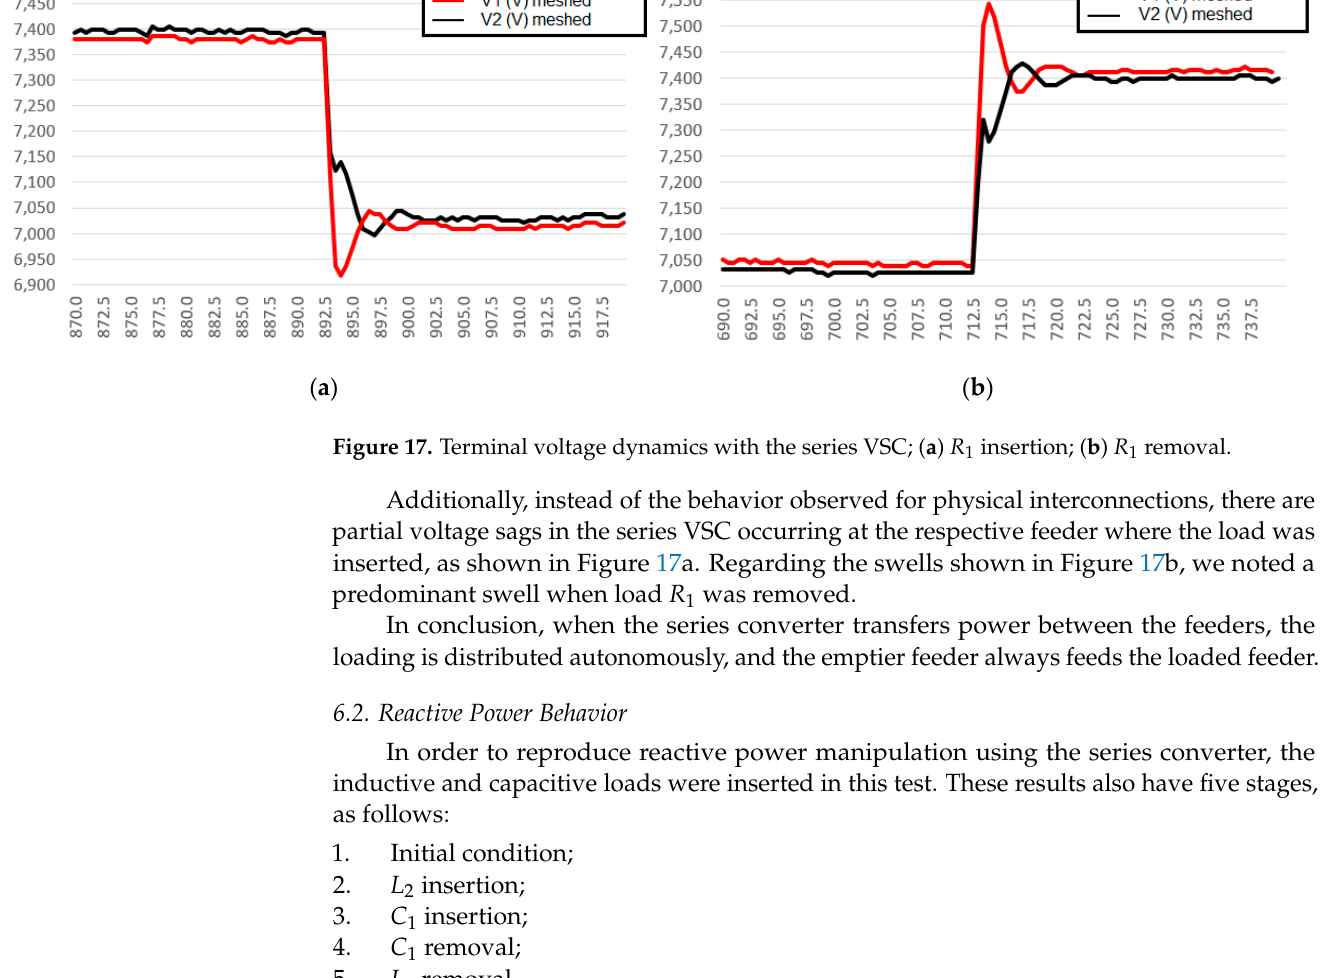
Figure 18. Phase-to-ground terminal voltages behavior and power flow; ( a ) V 1 and V 2 ; ( b ) transferred P and Q.